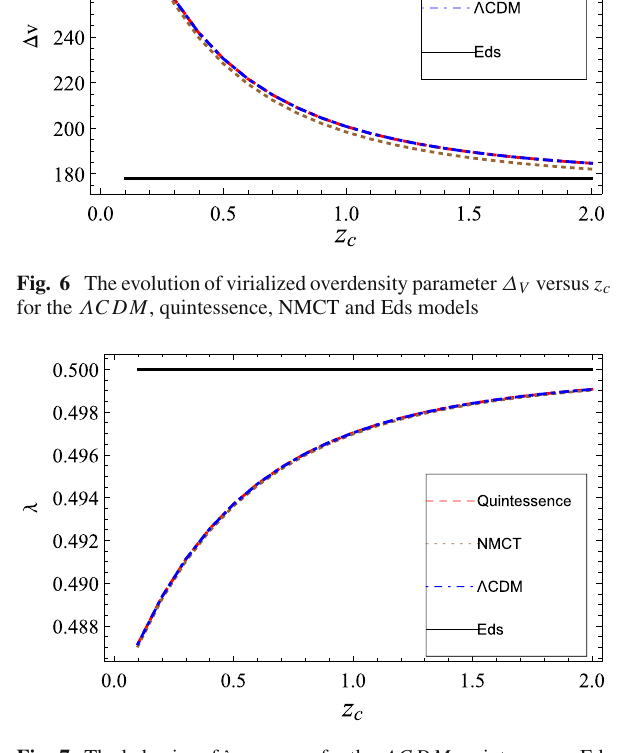
Fig. 7 The behavior of λ versus z c for the Λ CDM , quintessence, Eds and NMCT models